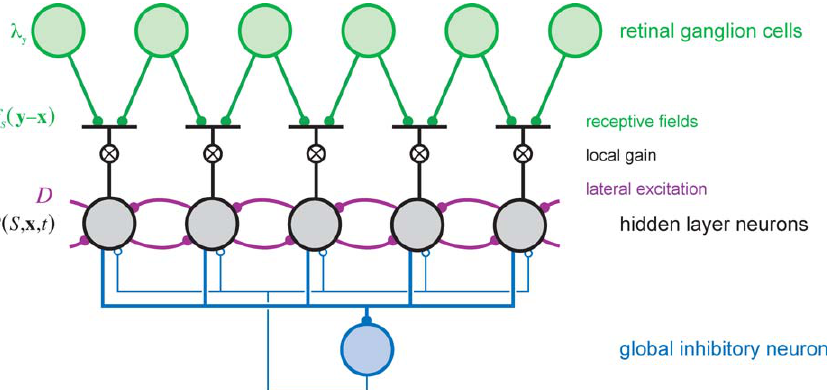
Figure 7. Schematic for a Network Implementation of the Markov Decoder (Equation 1) Spikes from retinal neurons (green, top layer) are collected by neurons in a hidden layer (black, middle layer) with linear receptive fields f S ( y (cid:2) x ) and a local gain that is set by activity in the recipient neuron. Global divisive inhibition is driven by the total activity of all neurons in the hidden layer through a pooling neuron (blue, bottom neuron).